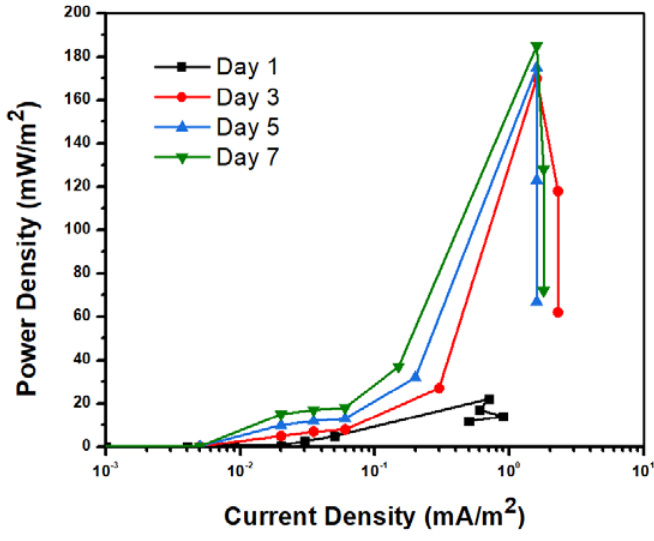
Figure 4. Variation of power density with a current density of